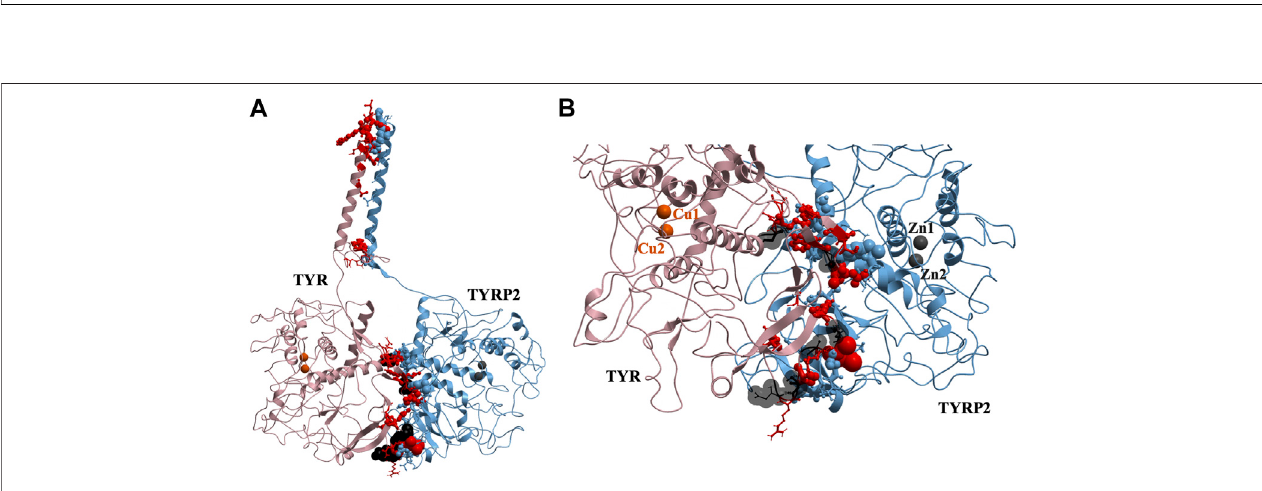
FIGURE 3 | Protein-protein interaction surface between TYR and TYRP2. Residues making key contacts are displayed in ball-and-stick (radius represents contributionsize). (A) .Fullsizedimerwithhelixbundle. (B) .37contactresidueshighlightedattheinterfaceofthetwoproteins.Residueswheremutationassociatedwith OCA1A occurs, is shown in black. Two Zn atoms in the active site of TYRP2 are shown in gray. Cu atoms in the active site of TYR are shown in orange.